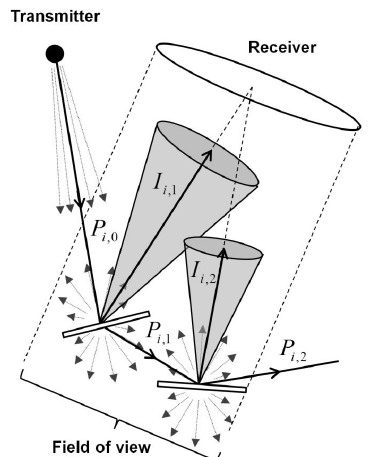
Figure 2. Illustration of the MCRT sampling scheme. The dashed small arrows represent the populations of all possible photon paths that are sampled. Note that in reality the receiv- er and transmitter are at the same location in LiDAR sensors. By setting the total power of the emitted rays at 1, the output from the MCRT is directly the target (cid:305) . To account for the time-dependency of the LiDAR signal, (cid:305) was binned into 0.05-ns-long intervals (cross-section profile, (cid:305) ( t )) based on the lengths of the individual ray paths. We used 30000 rays per pulse and 10 scattering orders in the